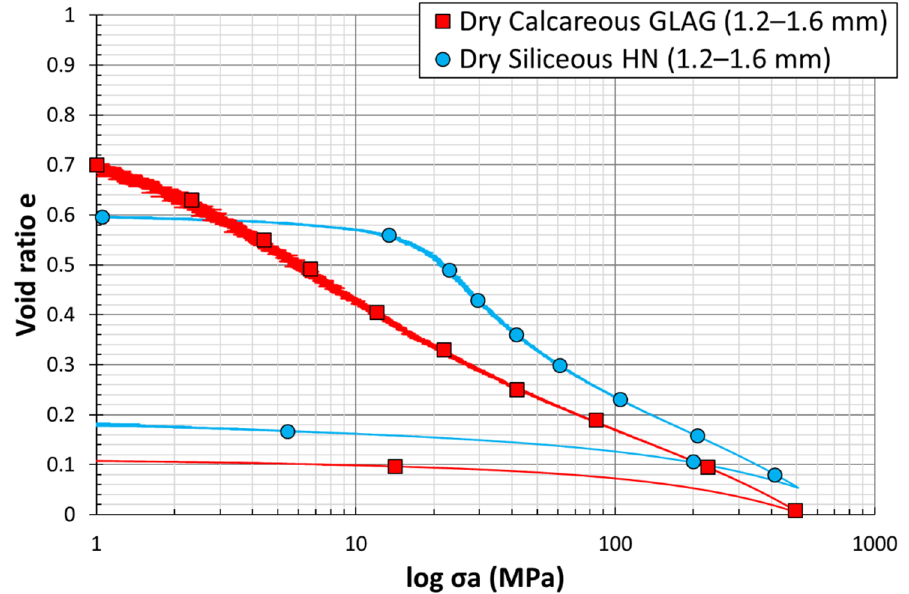
Figure 14. Load–settlement curves from dry odometer tests on siliceous and calcareous sand grains of same size (1.25–1.6 mm).